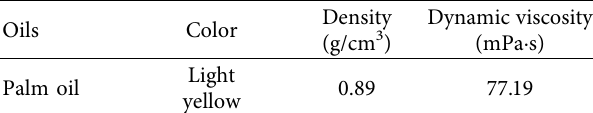
Table 1: Properties of palm